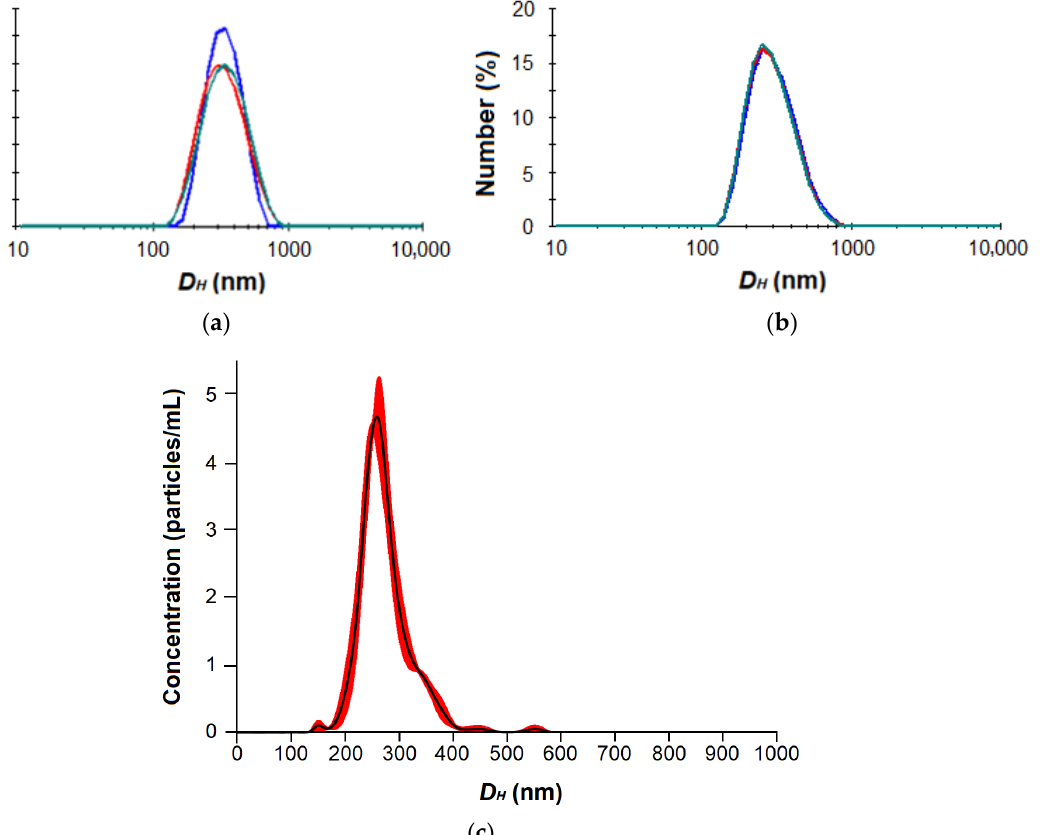
Figure 4. DLS by intensity ( a ) and number ( b ) as well as NTA ( c ) distribution curves for nanoparticles based on P[EE( R )E(H)E( I )E(Glc)] amphiphilic glycopolypeptide (the color curves reflect multiple measurements for the same sample, n = 3).